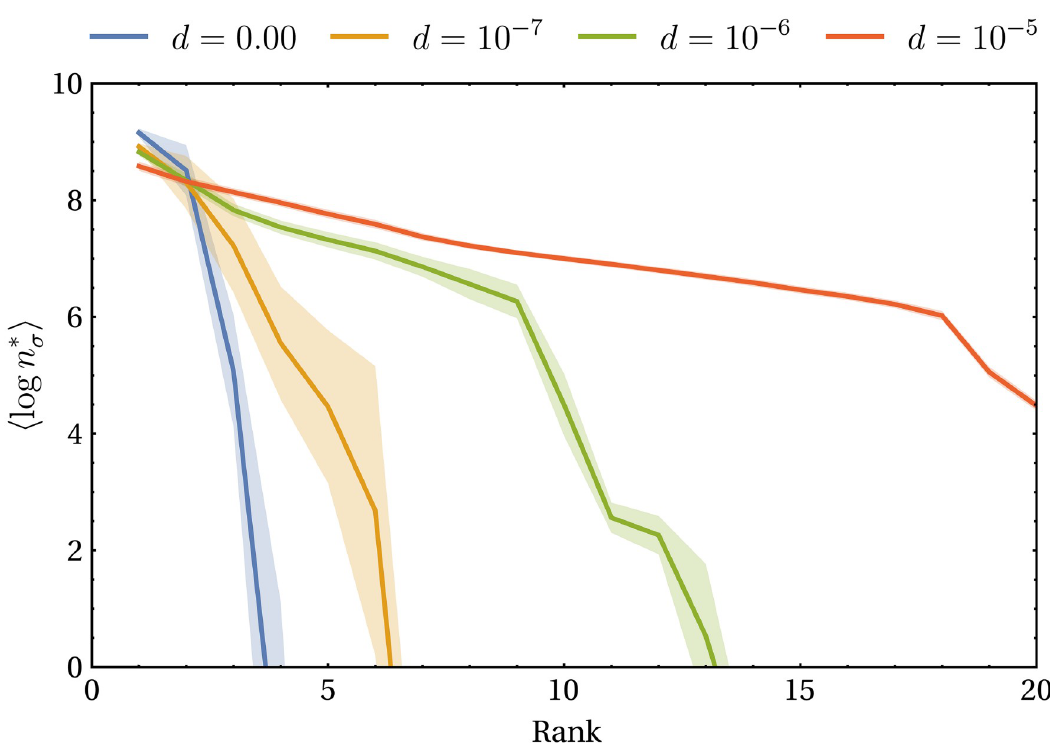
Fig 5. Rank distribution of the (decimal) logarithm of the stationary population densities n � for different values of the s adaptation velocity d (see Figure J in S1 Text for more information on the parameters used). The lines represent the average value over 100 iterations, while the opaque bands outline the standard error of the mean. For d = 0 (blue line) the rank distribution is very steep and only the first few species have a population density over 1 cell/mL (corresponding to log n � ¼ 0 ), while as d increases s ¼ 0 as the extinction threshold, approximately two thirds of the species in the the distribution becomes more even. Setting log n � s system go extinct with d = 10 − 7 (yellow line), while all of them survive with d = 10 − 5